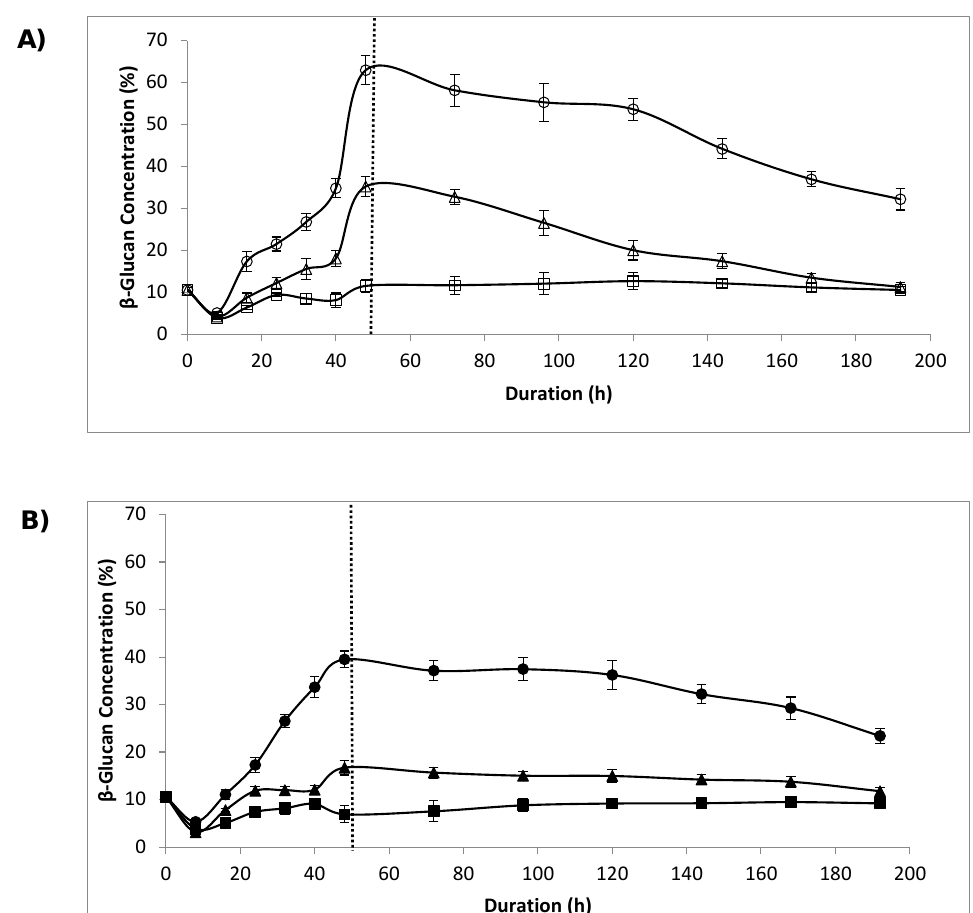
Figure 6. ( A ) Yeast cell wall β -glucan (%) of non-NaCl-stressed cells during various fermentation times (h) with three different media containing 200, 300, or 400 g/L glucose ( n = 3 replications for each time and error bars represent standard deviation of the average value of all replications with each range of fermentation time). Mean values between 0–144 h were significantly different at p ≤ 0.05 level. ( B ) Yeast cell wall β -glucan (%) of NaCl-stressed cells during various fermentation times (h) with three different media containing 200, 300, or 400 g/L glucose ( n = 3 replications for each time and error bars represent standard deviation of the average value of all replications with each range of fermentation time). Mean values between 0–144 h were significantly different at p ≤ 0.05 level. The stationary phase is indicated with the vertical line.